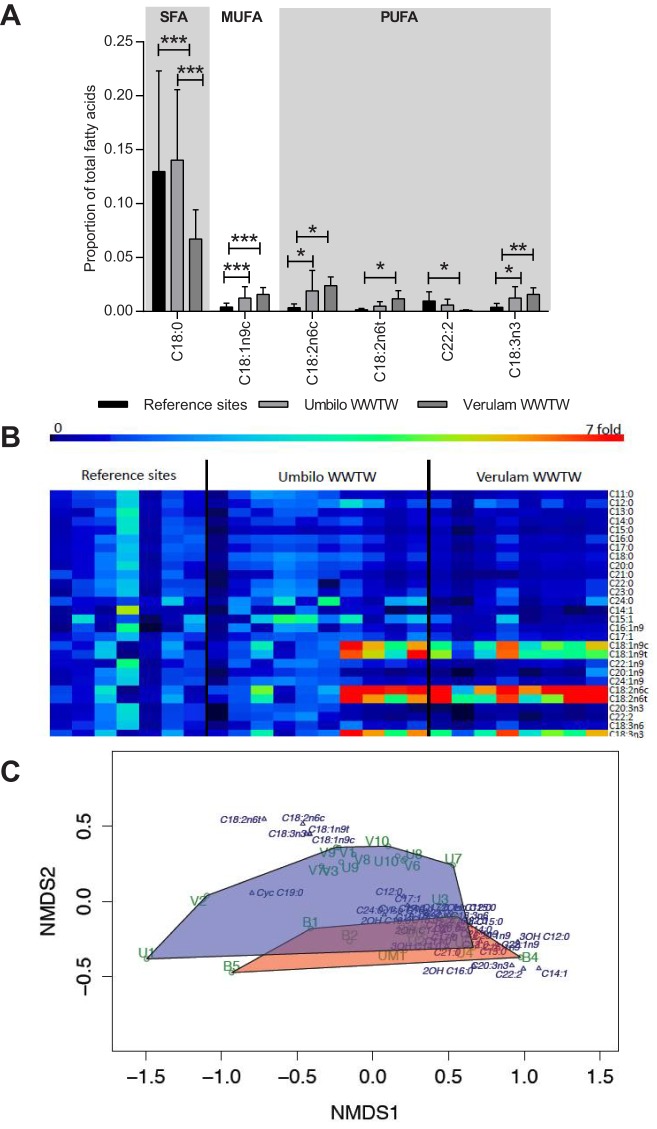
Phospholipid fatty acids in N. nana brown adipose tissue. (A) Mean BAT phospholipid fatty acid concentrations (error bars=s.d.) in brown adipose tissue of N. nana bats collected from reference sites, Verulam WWTW and Umbilo WWTW. Asterisks indicate significant differences between sites as derived from two-way ANOVA followed by Tukey's multiple comparisons test. *P<0.05; **P<0.01; ***P<0.001. Only fatty acids that were significantly different between sites are shown. (B) Heat map representing fatty acid concentrations in brown adipose tissue of individual bats relative to the average of the reference site, with each column presenting an individual bat. (C) Non-metric multidimensional scaling of fatty acids of bats. Convex hulls connect bats from polluted sites [U (Umbilo WWTW) and V (Verulam WWTW)] and unpolluted sites [UM (Umdoni) and B (Buffelsdrift farm)]. The blue shaded area represents WWTW bats, and the orange shaded area represents reference site bats.